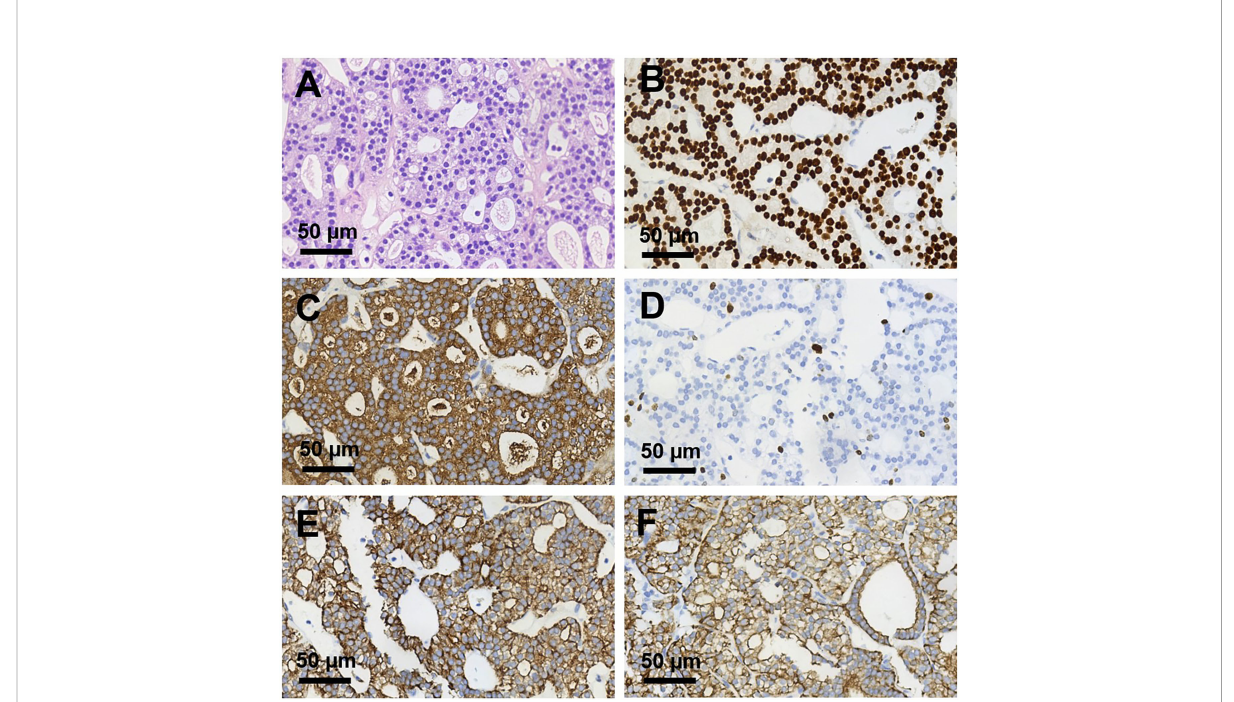
FIGURE 2 Histopathological sections of right humerus lesion (magni fi cation, ×400). (A) H&E staining and (B – F) Immunohistochemical staining of (B) TTF-1, (C) TG, (D) Ki 67, (E) CK pan, (F) CK 7. TTF-1, TG, CK pan, and CK7 were deeply stained (positive); Ki 67 proliferation index was about 10%.